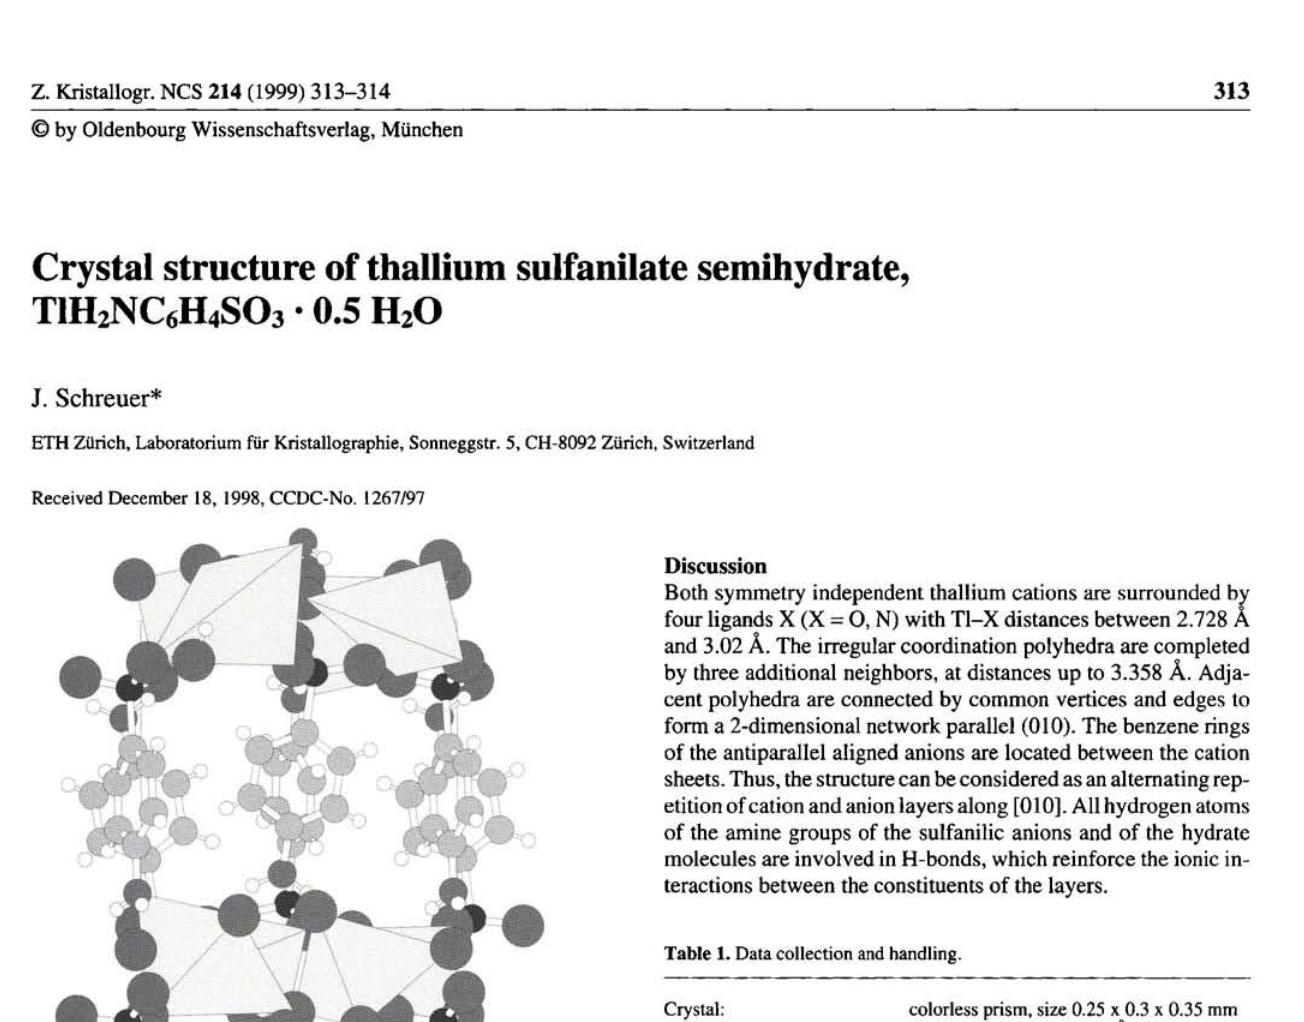
Table 2. Atomic coordinates and displacement parameters (in Â 2